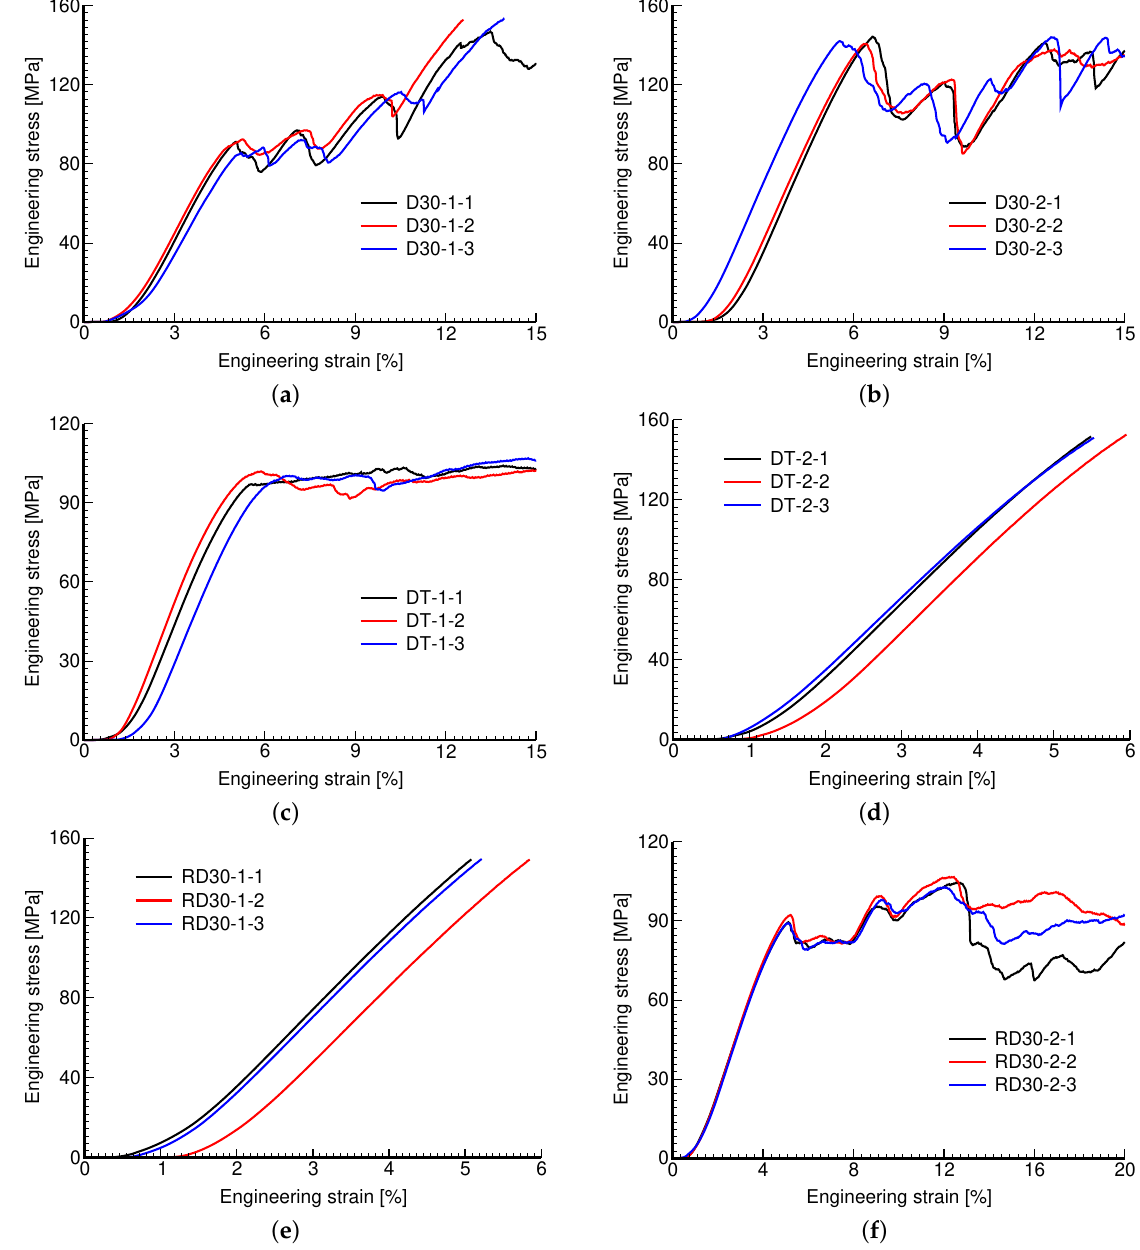
Figure 10. Engineering stress vs. engineering strain curves: ( a ) D30-1, ( b ) D30-2, ( c ) DT-1, ( d ) DT-2, ( e ) RD30-1, ( f )